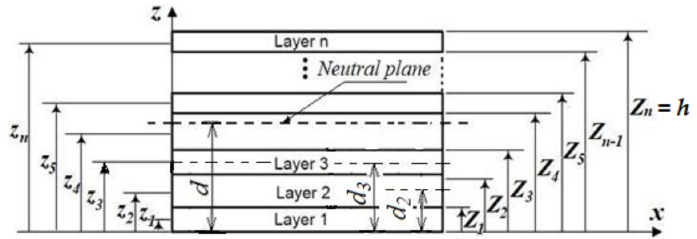
Figure 19. Calculus model for determining the position of the neutral plane.